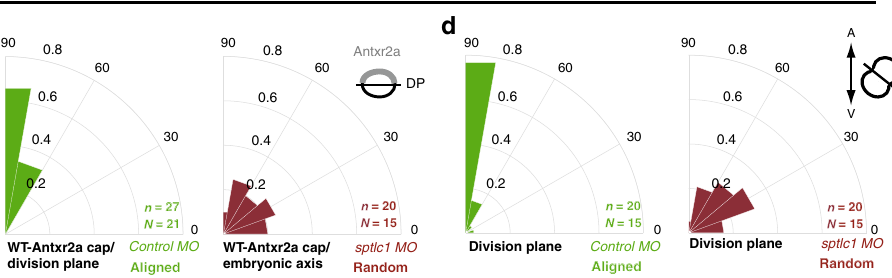
Fig. 6 Alignment of F-actin and Antxr2a caps with the division plane requires sphingolipids. a , c Polar graphs showing the frequency distribution of the angle between the F-actin cap ( a ) or the Antxr2a cap ( c ) with respect to the mitotic plane (green line in Fig. 5b, e). b , d Polar graphs showing the frequency distribution of the angle between the plane of division and the plane of the embryonic axis in epiblast cells expressing either Lifeact-mRFP biosensor ( b ) or Antxr2a-eYFP ( d ) in control and sptlc1 morphant embryos. χ 2 test was used (see Supplementary Table 1). n (number of cells analyzed) over N (number of embryos). DP division plane. Source data are provided as a Source Data fi